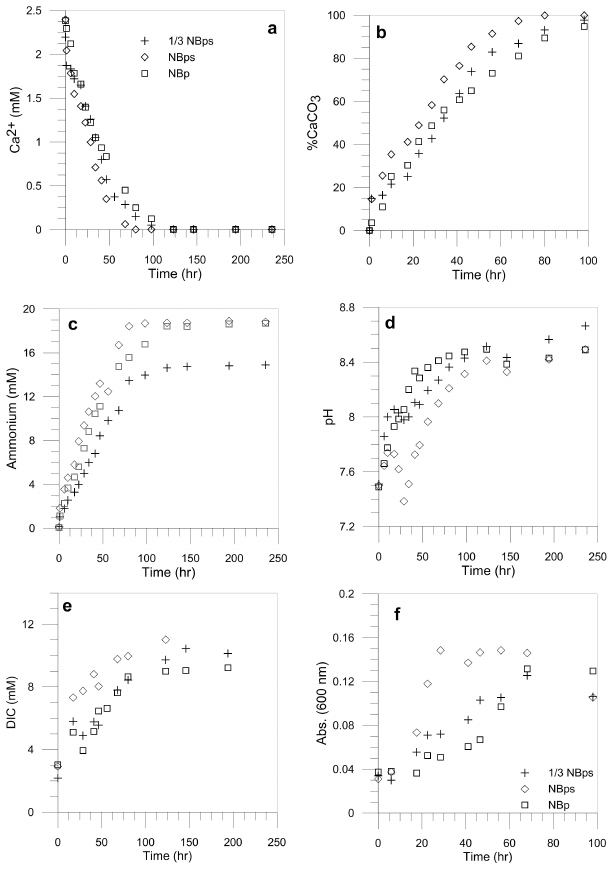
Fig. 1. Changes over time in dissolved calcium concentration (a) ; percentage of calcium depleted and precipitated as CaCO 3 (b) ; am- monium (c) ; pH (d) ; dissolved inorganic carbon (DIC) (e) ; and OD at 600nm (f) ; for treatments NBp ( (cid:3) ), NBps ( ♦ ) and 1 / 3 NBps ( + ). Note the different timescales in panels (b) and (f)